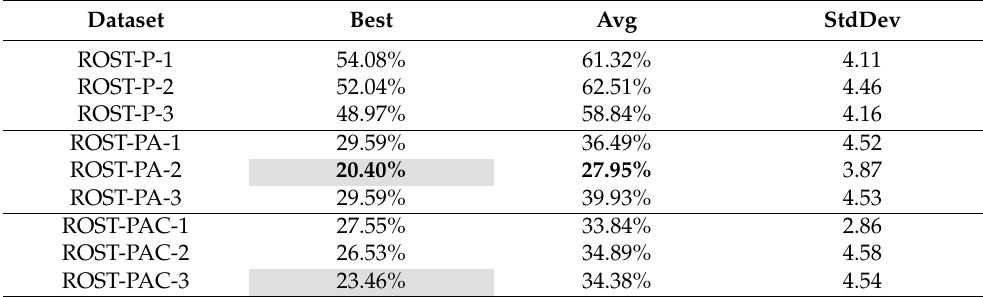
Table 12. MEP results on the considered datasets. A total of 30 runs are performed. The number of incorrectly classified data is given as a percentage (the best results obtained by MEP on any ROST-*-* dataset representation are in bold). Best stands for the best solution (out of 30 runs), Avg stands for Average (over 30 runs) and StdDev stands for Standard Deviation . The best result obtained by MEP compared to all methods for a given ROST-X-n dataset representation is in a gray cell.